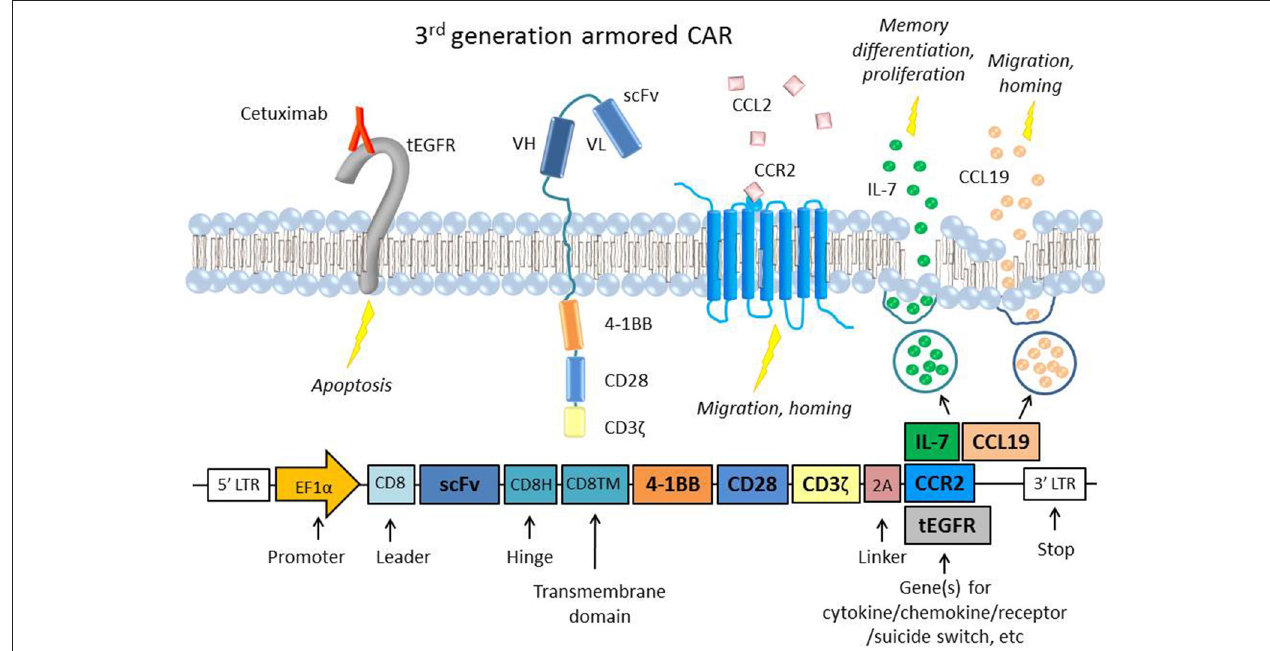
FIGURE 1 | A representative figure of an armored 3rd generation CAR in a T cell and a schematic of the transgene, which includes the extracellular scFv, two intracellular costimulatory domains (4-1BB and CD28), the ζ chain, a 2A linker, and the gene of interest to be coexpressed (61, 62). Examples of “armor” added to the CAR T cell are the CCR2 receptor (63), which has been shown to increase T cell migration and homing to the tumor site (64, 65) or constitutive secretion of the cytokine IL-7 and chemokine CCL19, which are important to memory differentiation and T cell migration, respectively (66). CARs that constitutively secrete IL-12 have also been used in several studies to boost survival and cytotoxicity (67). Also depicted is an example of an inducible suicide gene, tEGFR, which consists of the truncated transmembrane and extracellular portion of the EGFR protein. When targeted by the antibody Cetuximab, the receptor triggers apoptosis in the cell, providing a safety switch to protect against potential toxicity (68). Inducible caspase 9 (iC9) and HSV-TK are other common suicide genes that have been coexpressed with